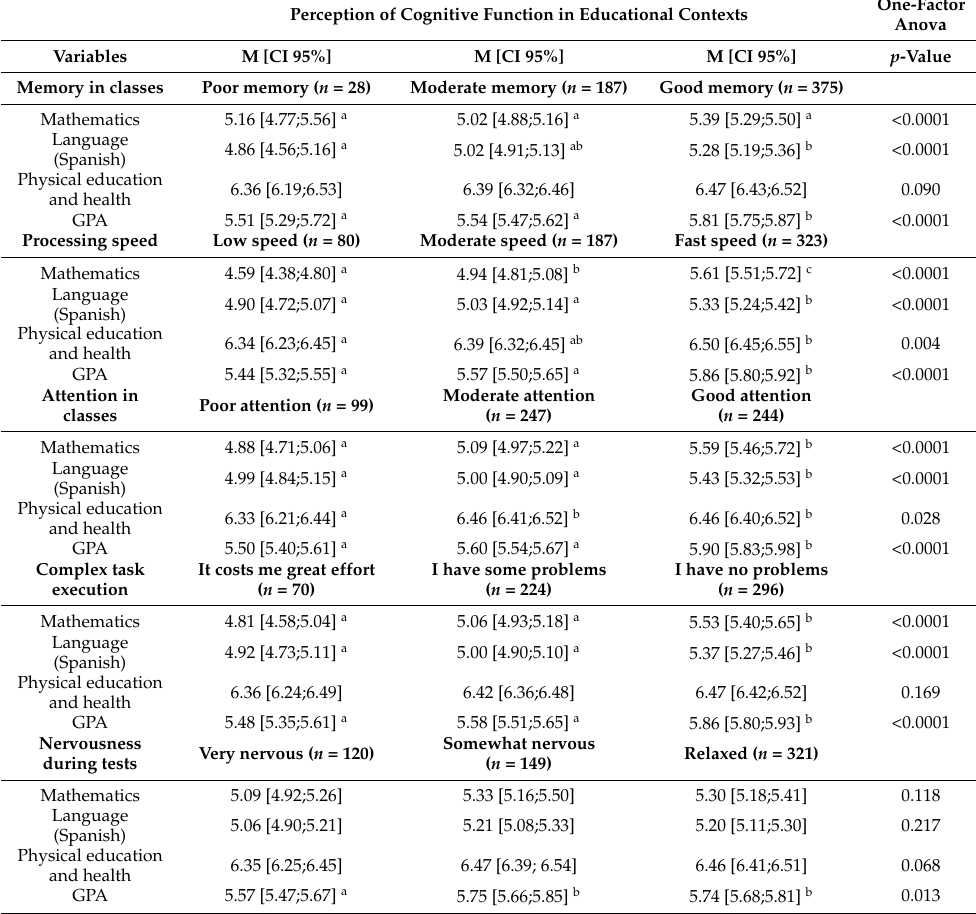
Table 3. Academic performance according to perception of cognitive function in educational contexts. Perception of Cognitive Function in Educational Contexts One-Factor